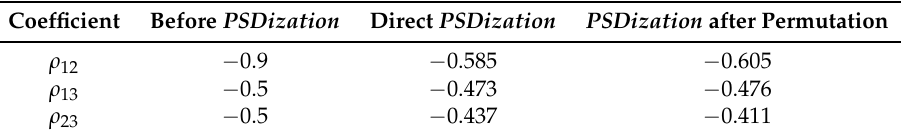
Table 3. Modification of initial correlation coefficients due to permutations of risks.